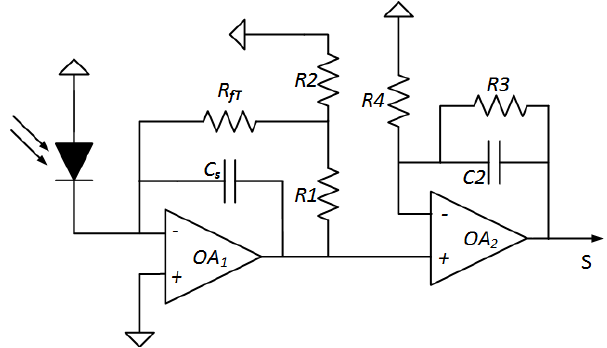
Figure 5. Dual stage transimpedance amplifier with resistive-tee